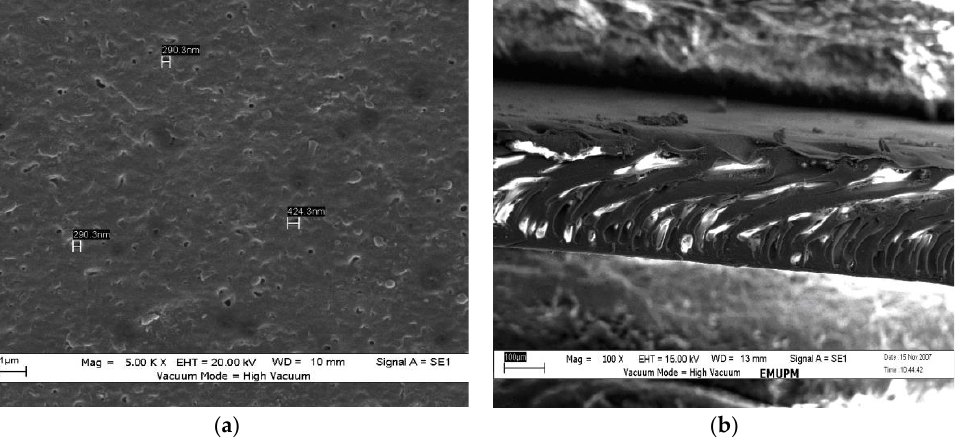
Figure 3. SEM images: ( a ) top surface of the hydrophilic membrane and ( b ) cross-section of the hydrophilic